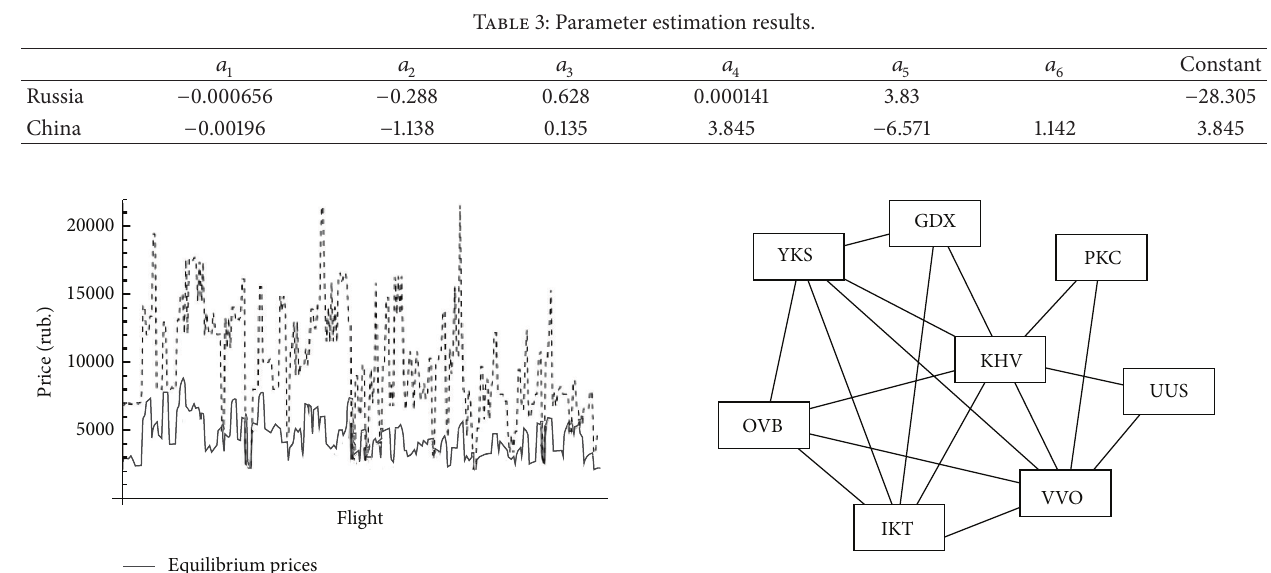
Figure 5: Market graph